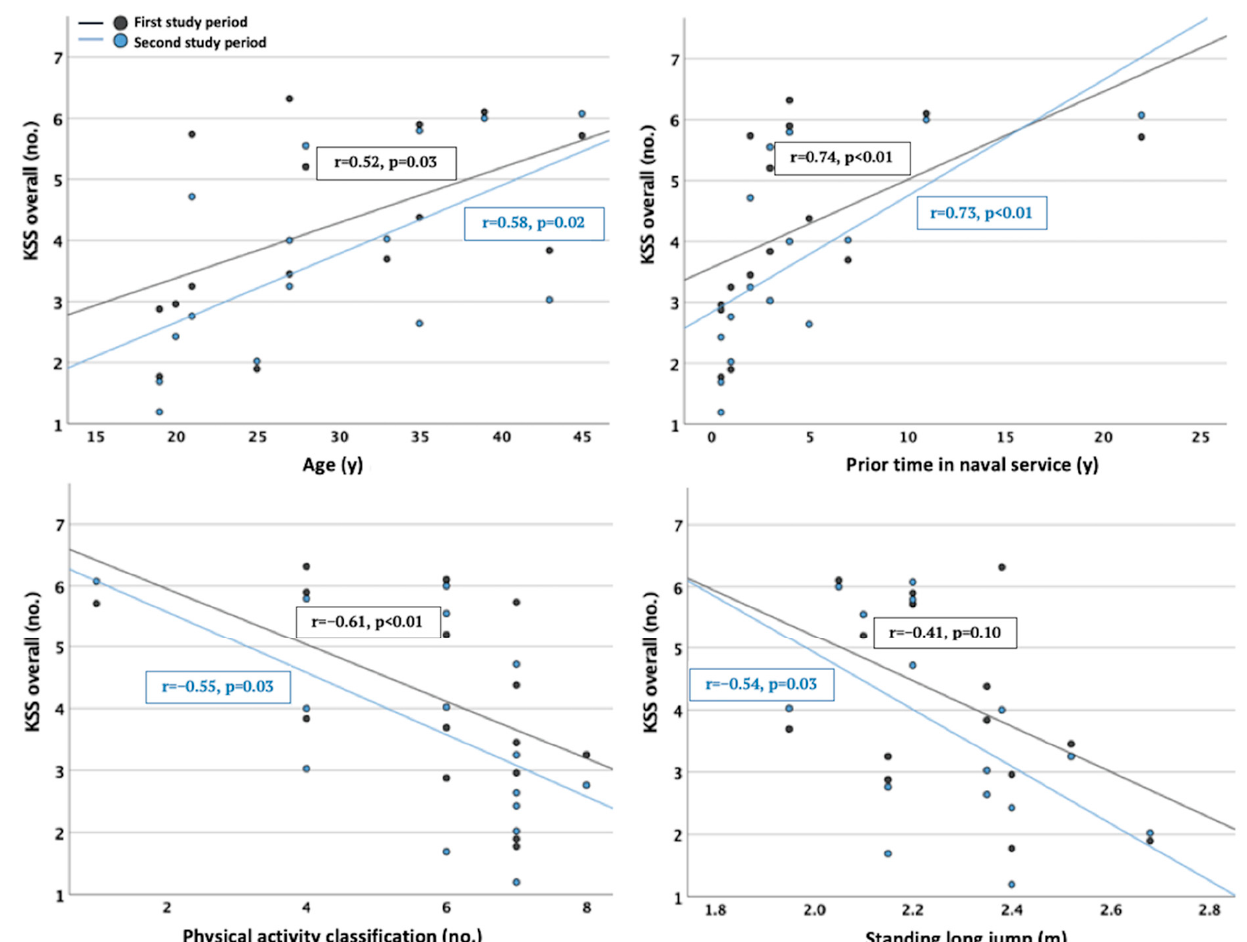
Figure 4. The correlations between the most distinct individual characteristics (age, prior time in naval service, physical activity and standing long jump) and mean Karolinska Sleepiness Scale (KSS) scores overall.